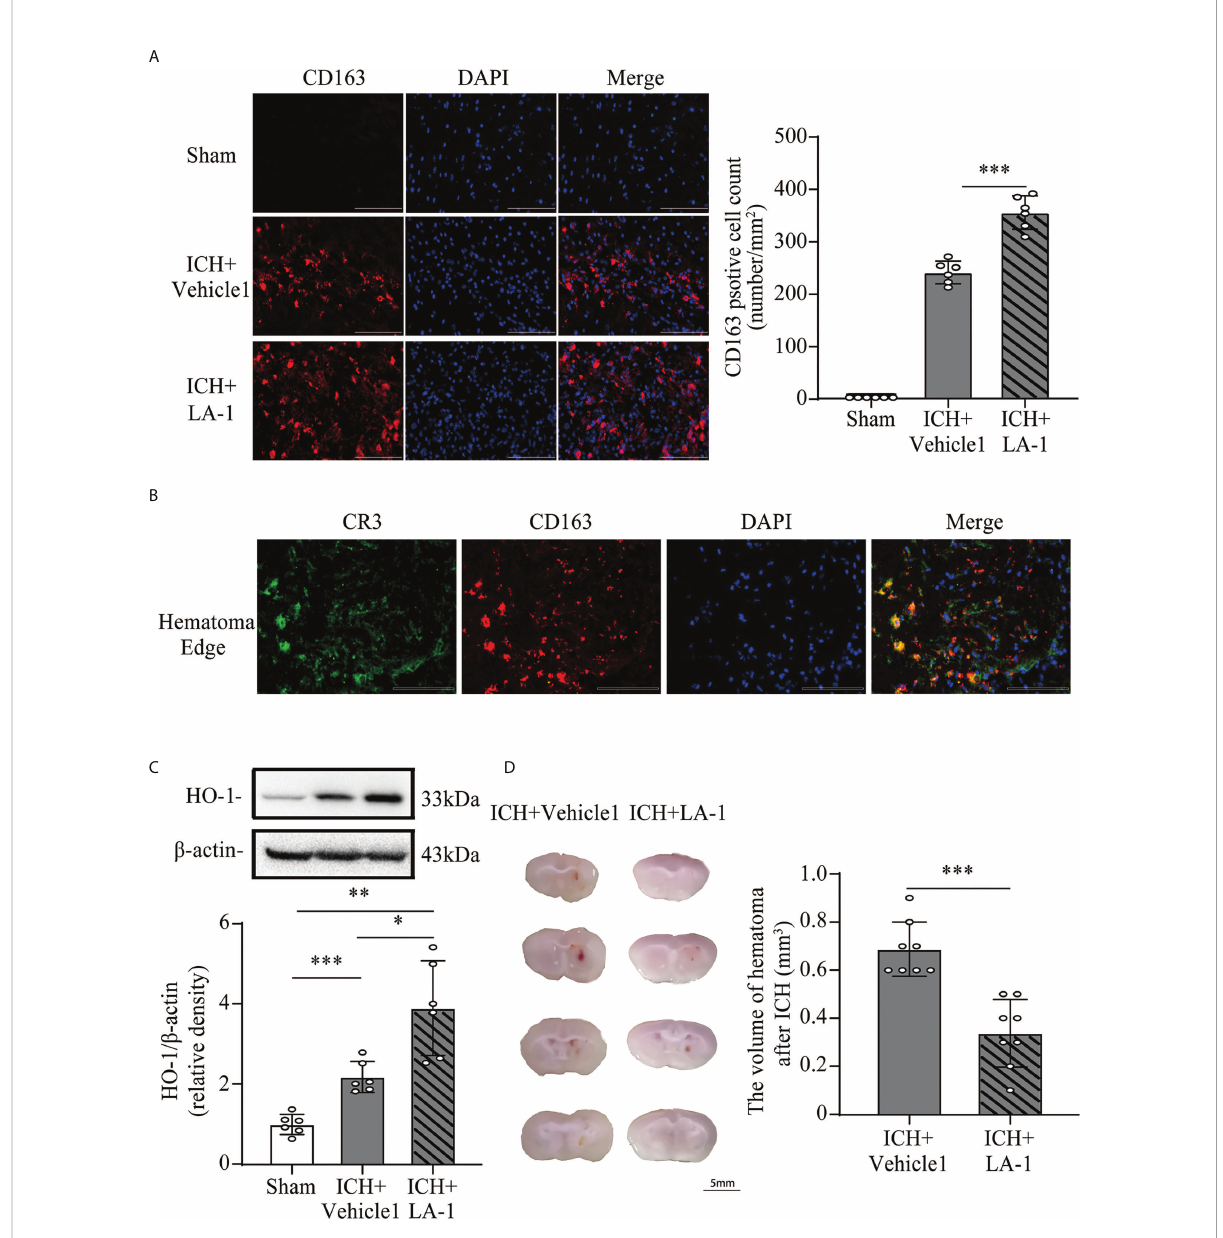
FIGURE 5 The effect of CR3 activation on the CD163/HO-1 pathway and hematoma resolution after ICH. (A) Representative immuno fl uorescent image and quantitative analysis of CD163 positive cell. Scale bar = 100 m m. n = 6. ***P <0.001 by one-way ANOVA. (B) Representative microphotographs of immuno fl uorescence double staining showing the localization of CR3 with CD163 in the perihematomal area after ICH. Scale bar = 100 m m. n = 3. (C) Representative western blotting images and quantitative analysis of HO-1. n = 6. *P <0.05, **P <0.01, ***P <0.001 by Brown-Forsythe and Welch ’ s ANOVA. (D) Representative brain section and quantitative analysis of hematoma volume. n = 8. ***P <0.001 by the Mann – Whitney test. Data are represented as mean ±